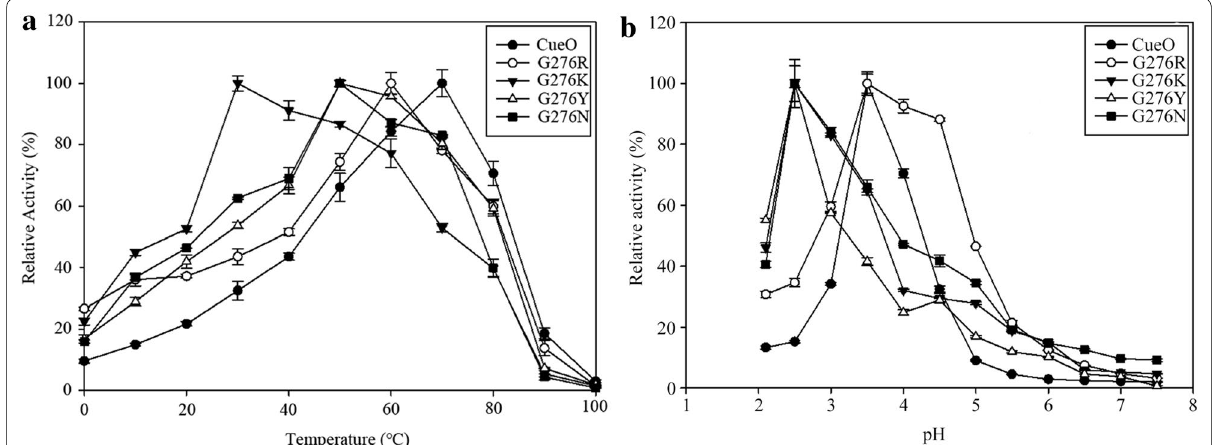
Fig. 5 Optimum temperature ( a ) and pH ( b ) of recombinant CueO and its mutants. To measure the optimum temperature, the pH of the experi- mental buffer was maintained at 4.5. To measure the optimum pH, the optimum temperature of the corresponding enzyme was